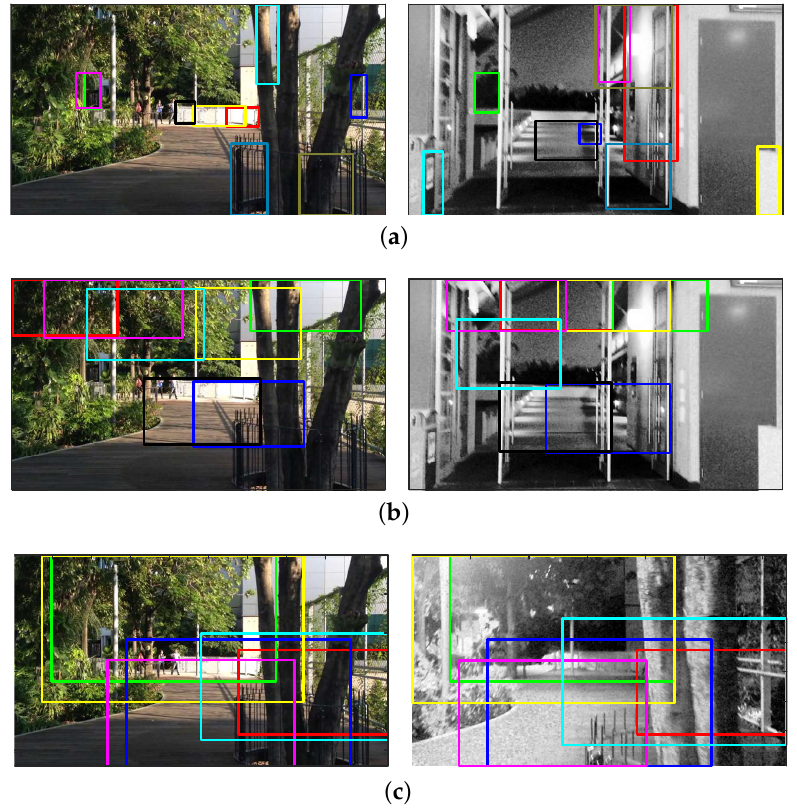
Figure 6. An example illustrating the pairwise matching results achieved by: ( a ) Edge Boxes; ( b ); SP-Grid; and ( c ) our MSW method. Both Edge Boxes and SP-Grid produced a false positive result, whereas our method produced a correct true positive result. It is shown that the failure of Edge Boxes is caused by the small objects, whereas that of SP-Grid is caused by the peaked distribution of landmark scale. Our method leads to true positive matches by utilizing the landmarks of appropriate distribution and